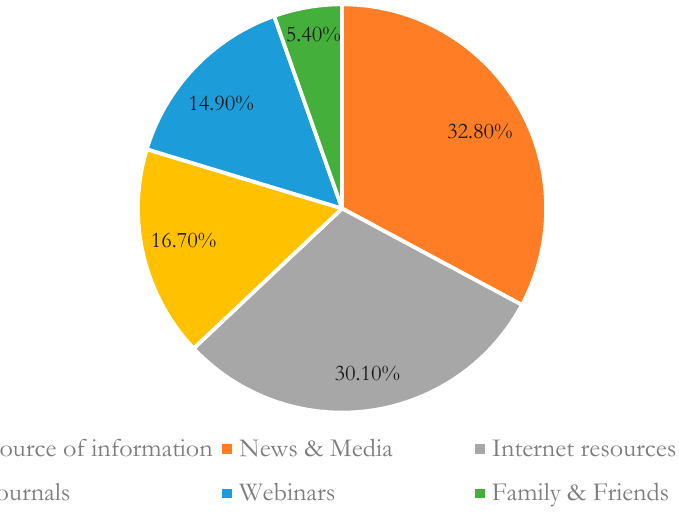
Figure 1. Sources of information related to COVID-19 reported by healthcare workers.